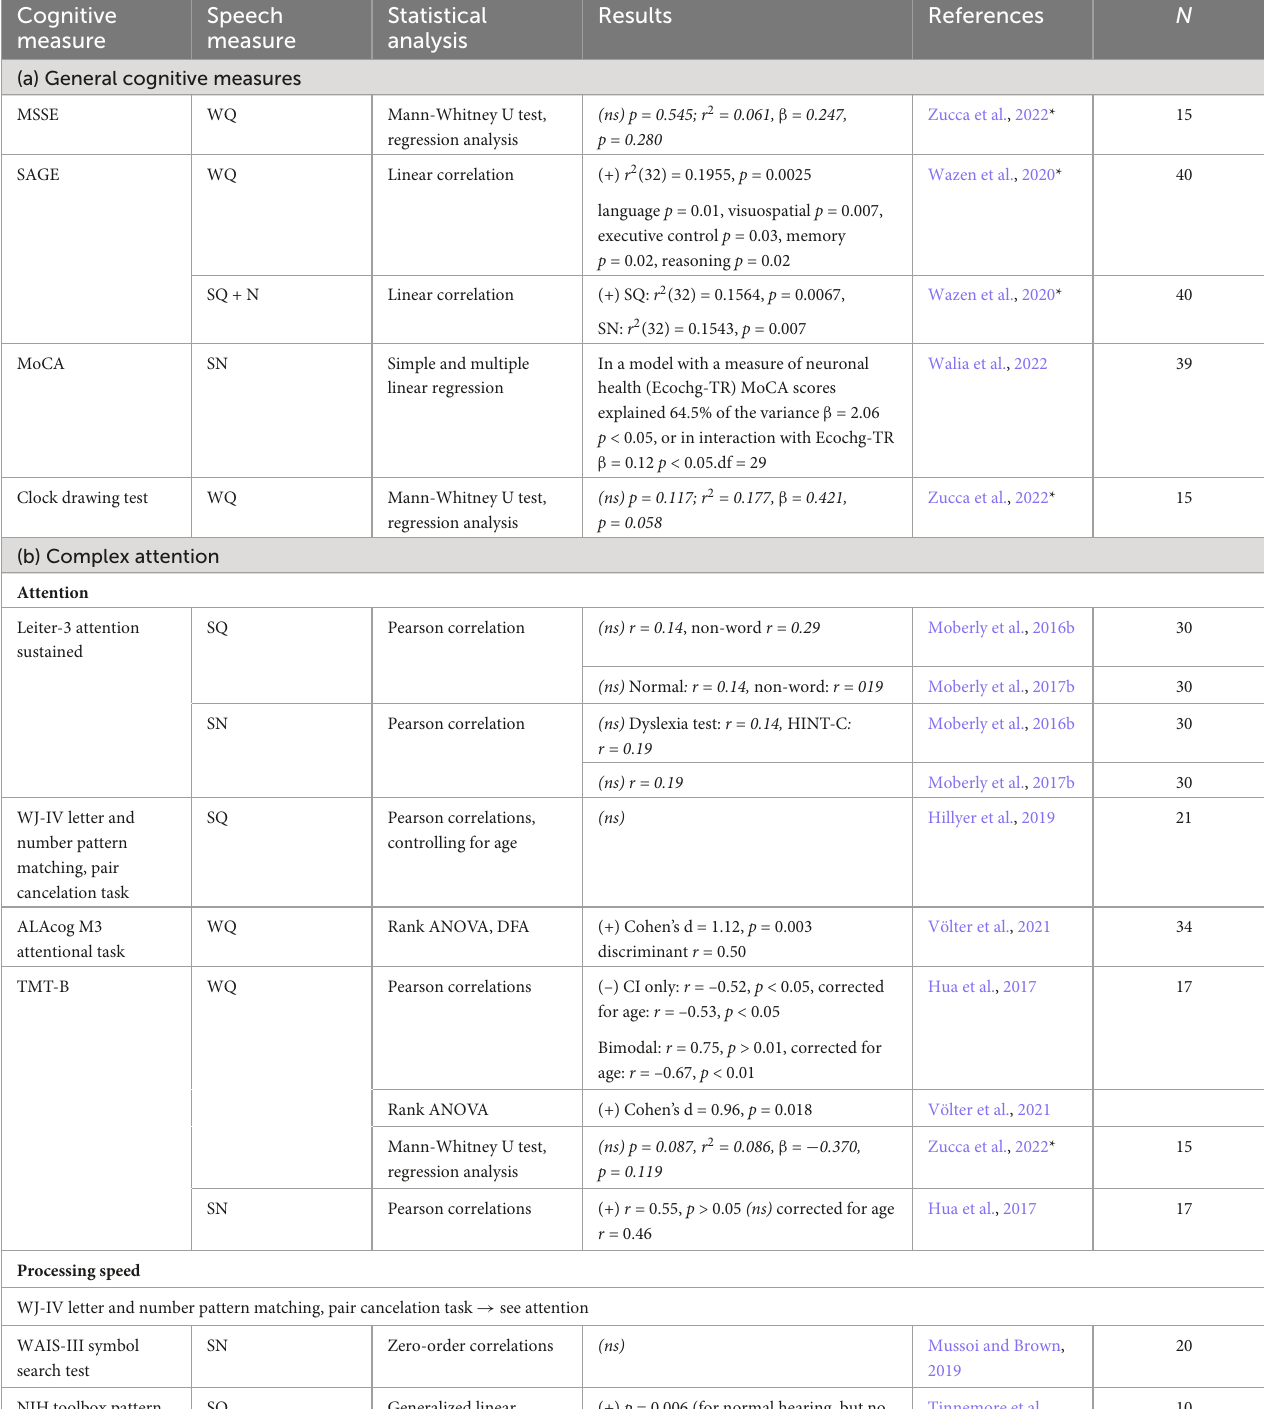
TABLE 5 Overview of included papers (a) using general cognitive measures and (b) studying complex